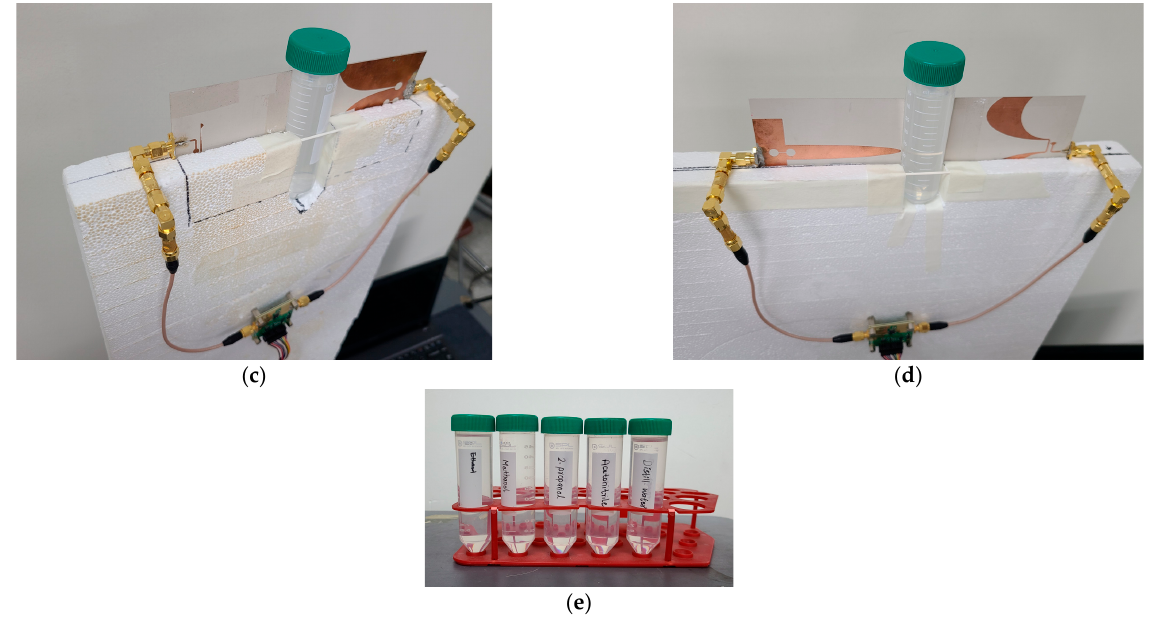
Figure 7. Experimental measurement setup: ( a ) proposed podal antenna scanning the MUT; ( b ) proposed antipodal antenna scanning MUT; ( c ) podal antenna with MUT side view; ( d ) antipodal antenna MUT side view and; ( e ) Test tubes containing the specimen.